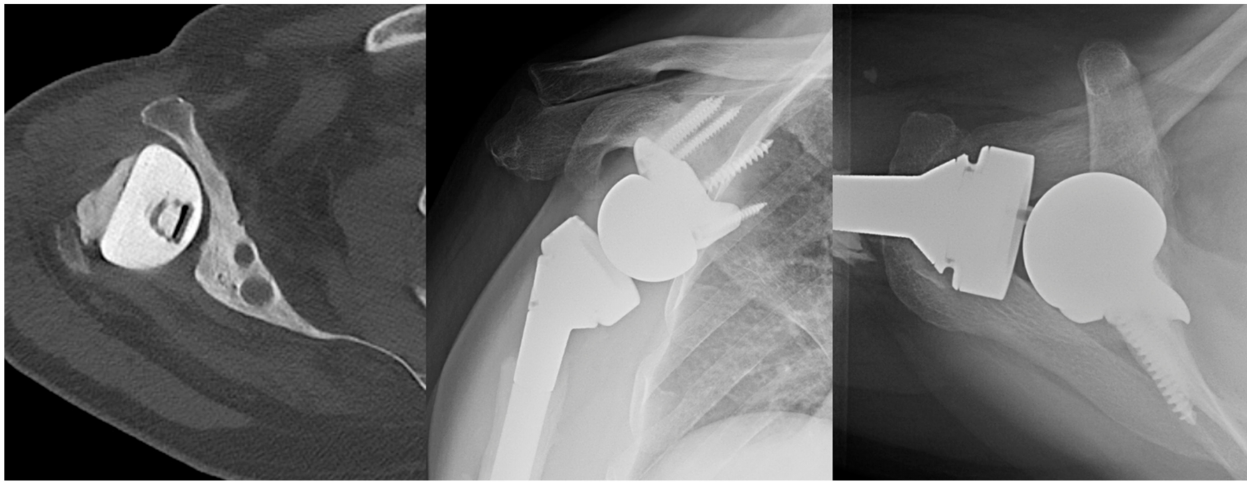
Figure 7. Case of severe glenoid bone loss treated with RSA with custom glenoid component. ( Left ) Axial CT scan of right shoulder status post antibiotic hemiarthroplasty spacer for prior prosthetic joint infection. ( Middle ) AP X-ray of RSA with custom glenoid component. ( Right ) Axillary X-ray of RSA with custom glenoid